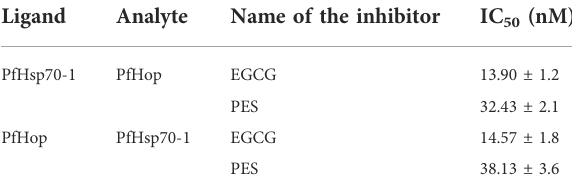
TABLE 2 Equilibrium binding af fi nities of PES for PfHsp70-1/PfHsp70- 1 NBD and PfHop.